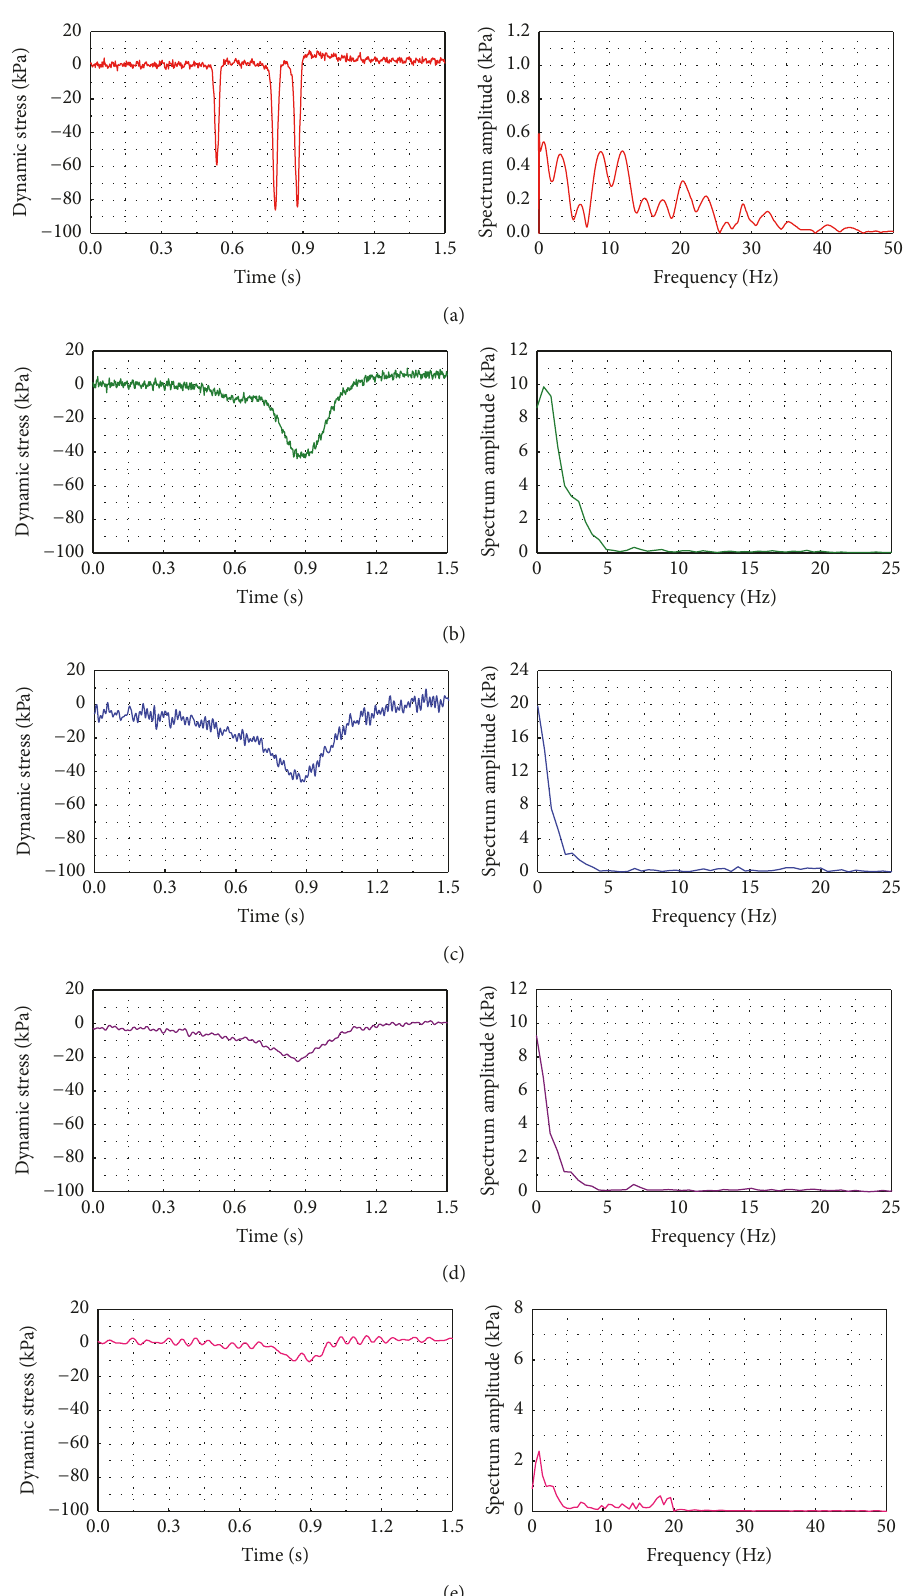
Figure 13: Dynamic pressure time history and spectrum curves when the depth is (a) 0.19 m, (b) 0.62 m, (c) 1.42 m, (d) 2.12m, and (e) 3.12